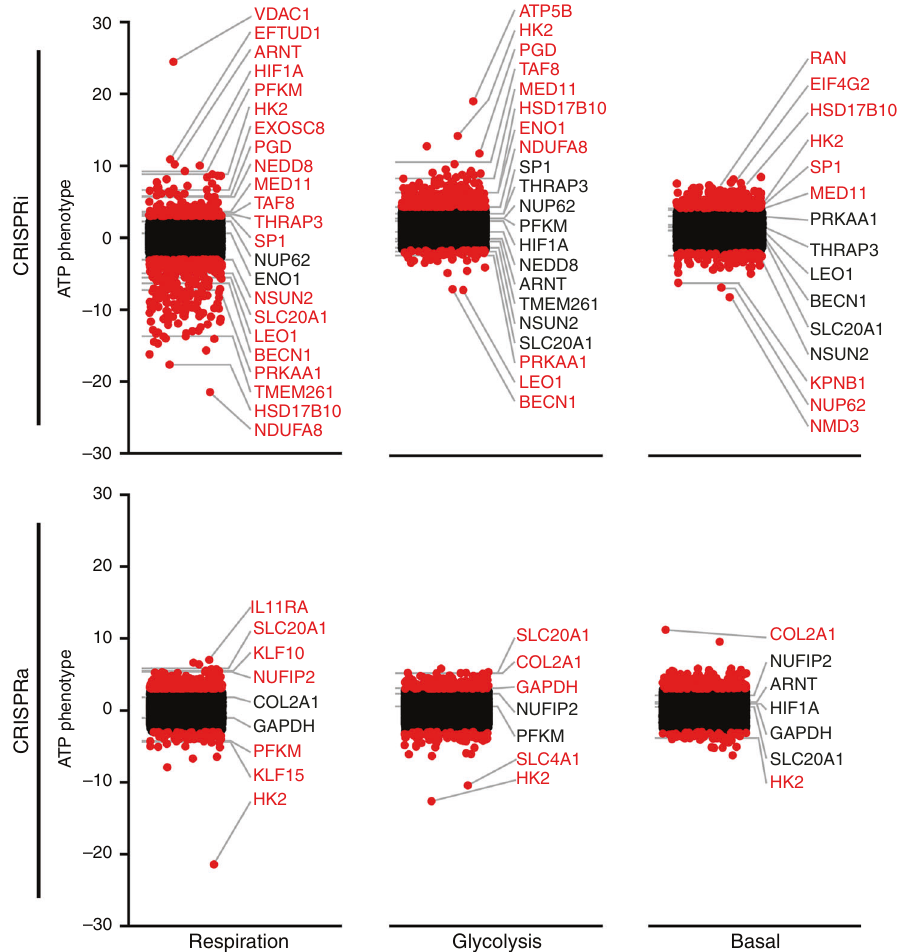
Fig. 3 Whole-genome summary of genes that alter ATP as a function of metabolic substrate. ATP phenotypes ( Z -scores) for each gene normalized to their respective sublibrary ’ s nontargeting guides, targeted with both CRISPRi and CRISPRa in respiratory, glycolytic, and basal metabolic substrates. Hits marked by red dots have phenotypes greater than three standard deviations from the mean of nontargeting guides. Labels identify genes with particularly robust phenotypes, or that are either members of notable classes or have characteristic responses to substrates discussed in the text. Source data are provided as a Source data fi